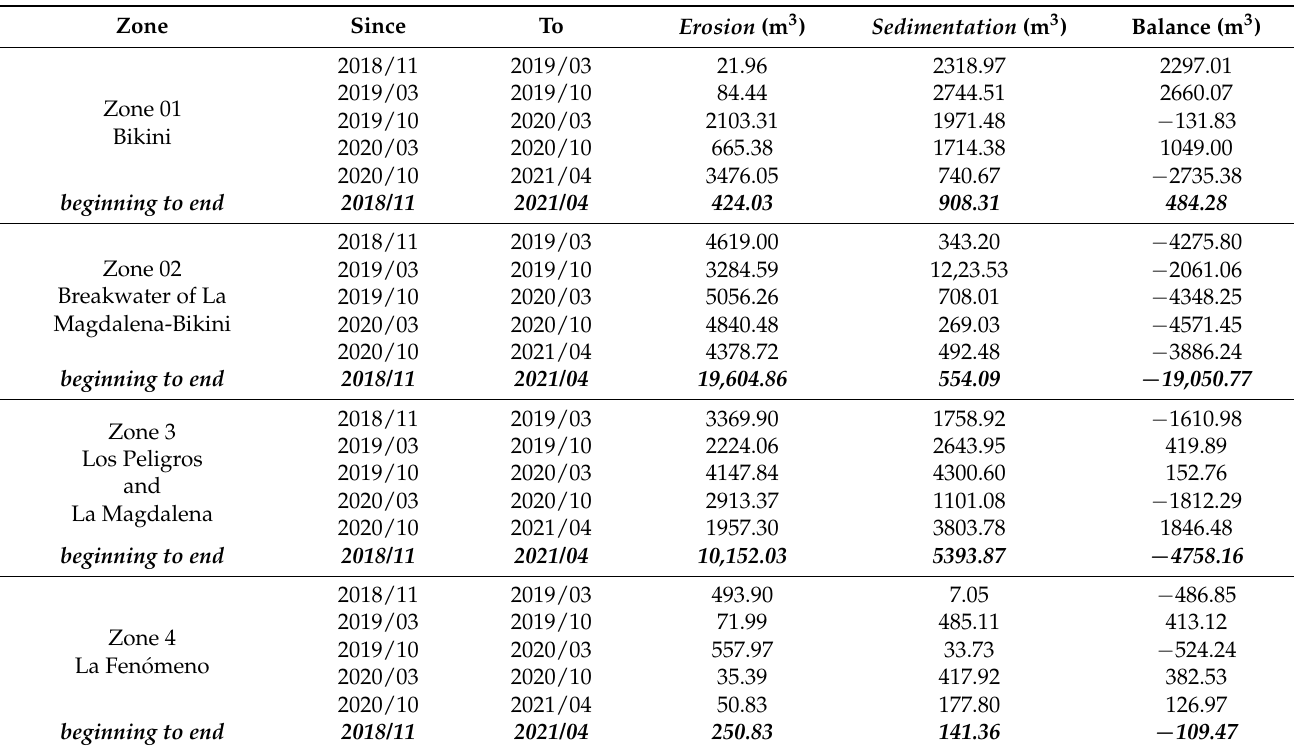
Table 3. Sedimentary balances (m 3 ) between two consecutive records and the total balance from November 6/2018 to April 19/2021, showing the general gains and losses of sand after the construc- tion of the breakwater in summer